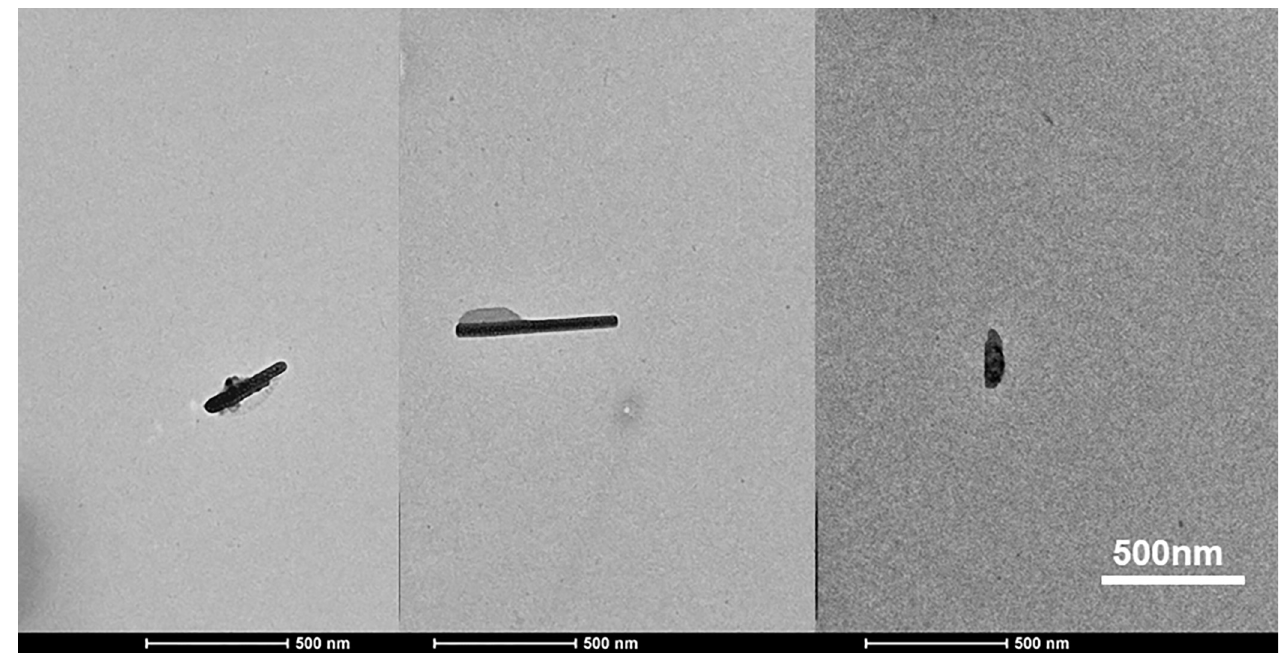
Fig 5. TEM micrographs of HPH-CNC (produced from 1 cycle at 50MPa).